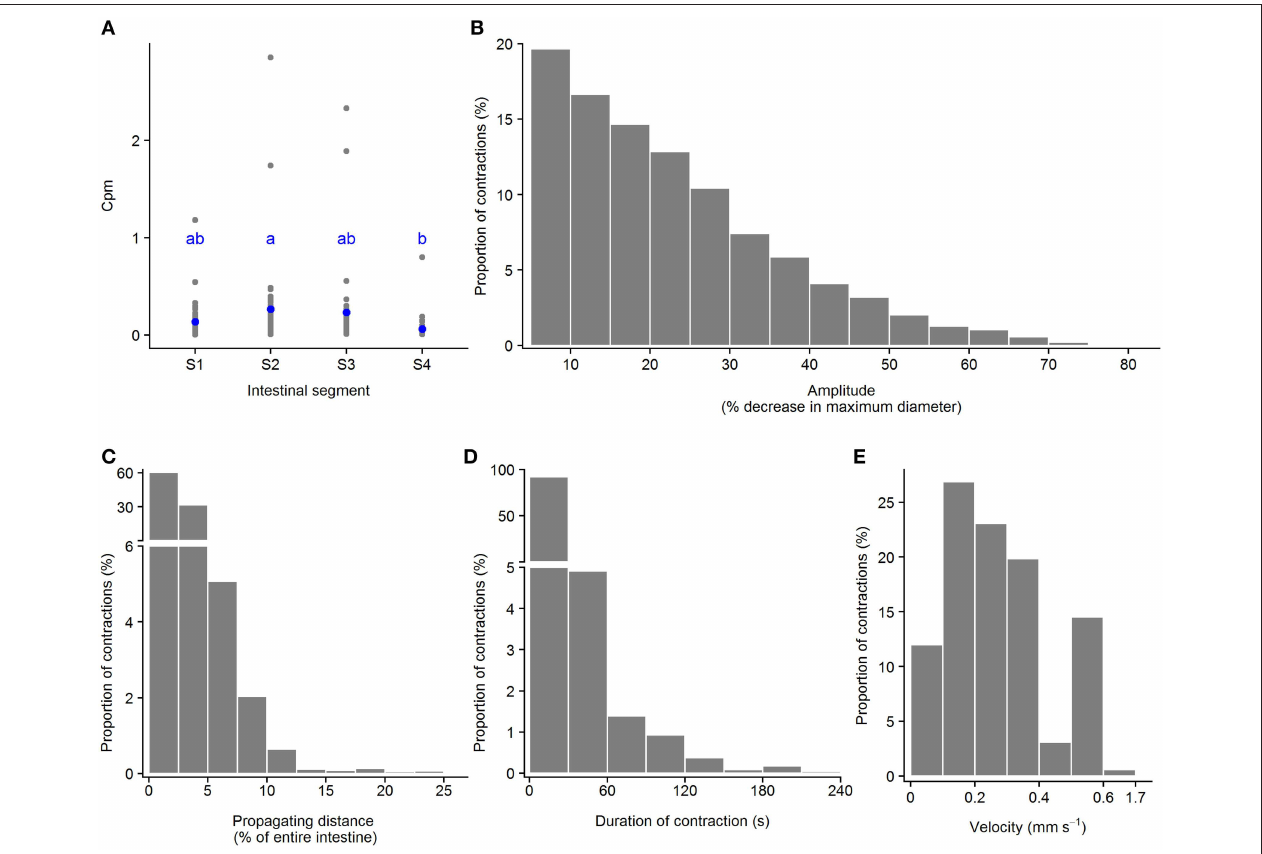
FIGURE 6 | Motility parameters for ripples in intestine of ballan wrasse juveniles. (A) Frequency of ripples (contractions per min. per mm gut length, cpm) in the four intestinal segments (gray dots for individual values and blue dots for mean value calculated from 21 fish); letters denote difference between segments (ANOVA, Tukey post-hoc test). (B) Amplitude was converted from mm to a relative value (%) in relation to the maximum diameter of the intestinal position where the ripple occurred; (C) Propagating distance; (D) Duration; and (E) Propagating velocity of ripples. (B–E) present histogram of data that was pooled from 21 fish. S1–S4, Segments 1–4 of the ballan wrasse intestine.